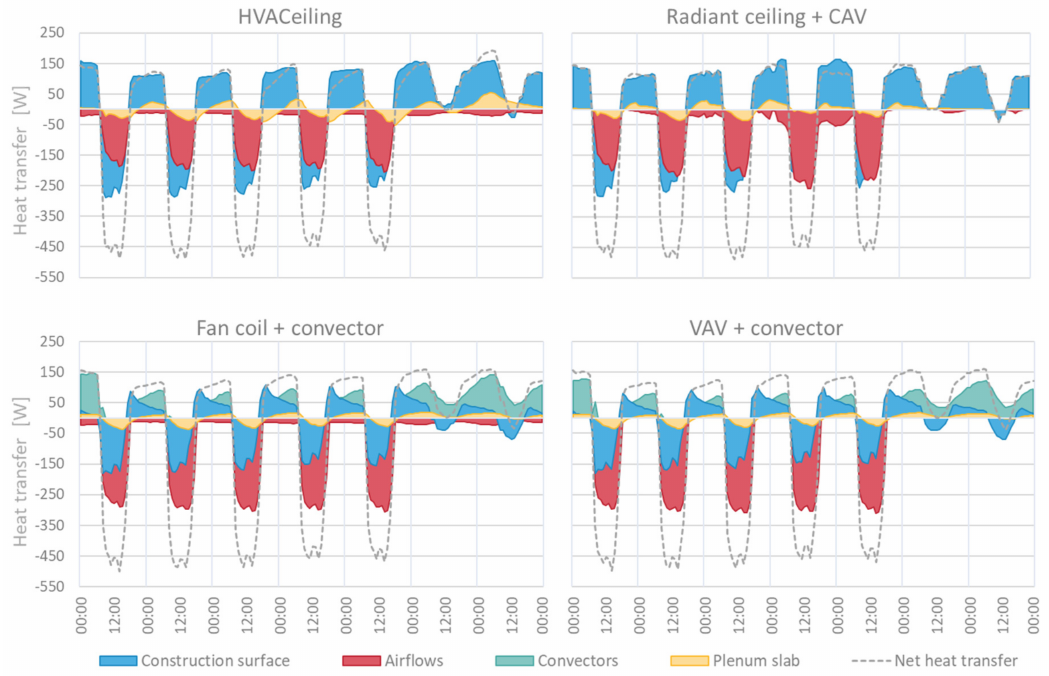
Figure 15. Heating/cooling from constructions, airflows, and heating/cooling units in a cold week in March (8th − 14th) for office N1. Time-series over week hours. The sign convention is positive for heat transferred into the room and negative for heat removed from the room. Net heat transfer is the absolute sum of heat